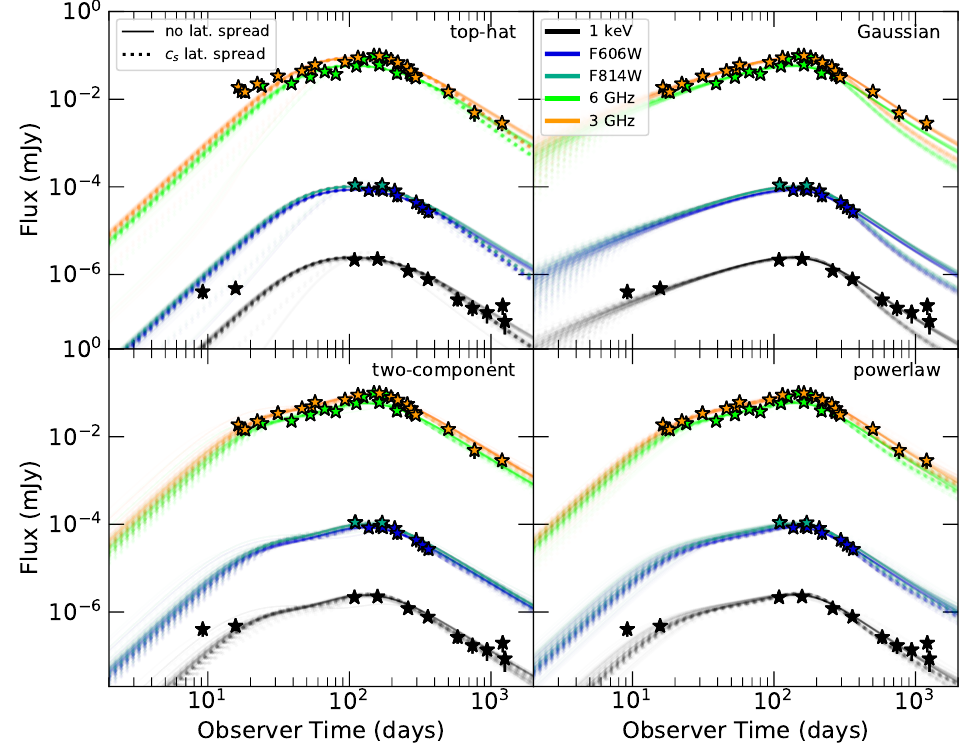
Figure 3. Afterglow lightcurve fits to the late-time afterglow to GW170817 at radio (3 and 6 GHz), infrared and optical ( Hubble Space Telescope filters F814W and F606W), and X-ray (1 keV). We use a Markov Chain Monte Carlo (MCMC) and plot a random sample of 100 lightcurves drawn from the posterior distributions. The four jet structures are top-hat (top left), Gaussian (top right), two- component (bottom left), and a powerlaw (bottom right) jet structure profiles. Each panel includes lightcurves with and without lateral spreading (dotted and solid lines respectively). Where the models with and without lateral spreading diverge we find that, typically, the model where lateral spreading is included will have a steeper decline immediately after the lightcurve peak—most obvious in the case of the Gaussian jet structure